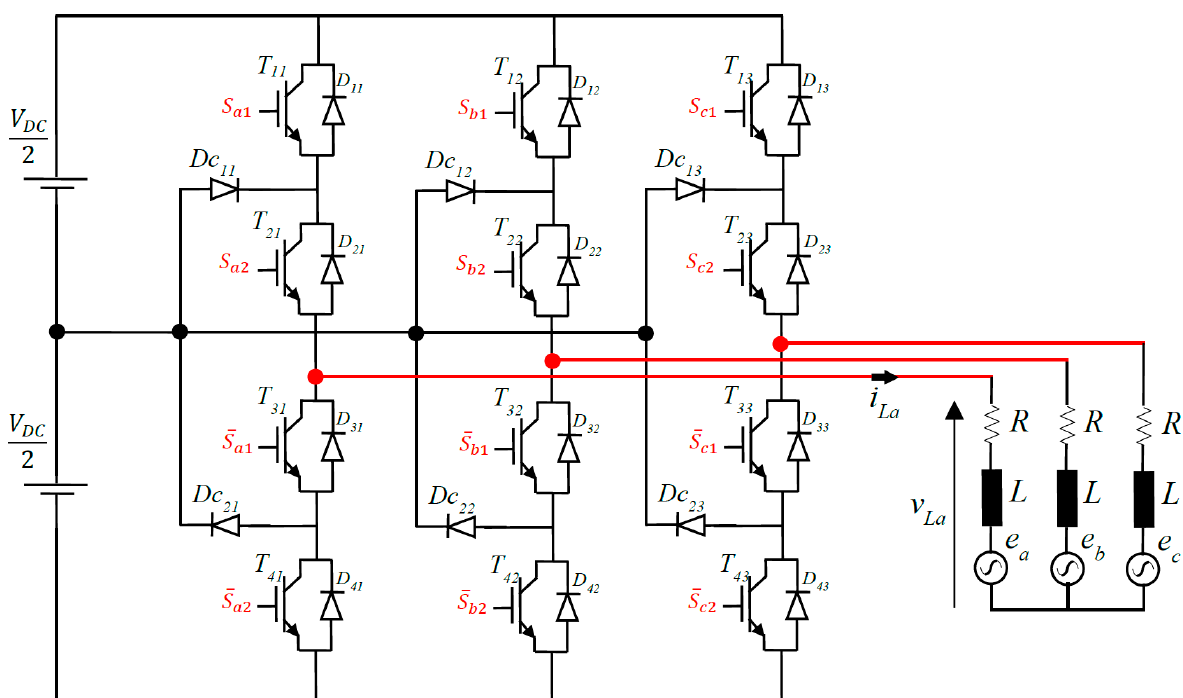
Figure 13. Topology of the three-phase NPC inverter supplying an RLE load. The controller generates three-phase sinusoidal voltage references assuming that the back-EMF terms are compensated. The amplitudes of these references are equally set to 0.9 pu (over V DC /2 = 300 V) and their frequency to 200 Hz. The 10 kHz PWM process can be seen in Figure 9. The RT results obtained with this operating condition are highlighted in Figure 14, which shows the load voltages ( v La , v Lb , v Lc ) and the load currents ( i La , i Lb , i Lc ). They are compared with Matlab/Simulink equivalent simulations, and the limited fixed-point precision (25Q18 format) introduces an average fitting error of less than 2%.